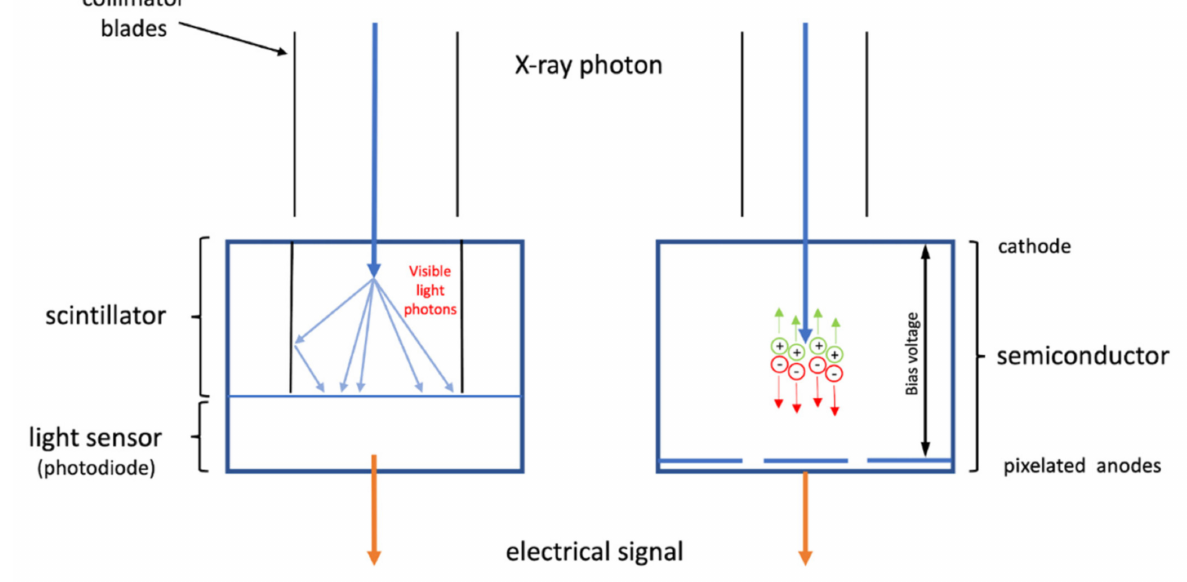
Figure 1. Schematic representation of two different CT systems as follows: on the left, an integrated energy detector (EIDs) with scintillator and septa. The X-rays absorbed by the scintillator are converted into visible light, and a swarm of photons is absorbed by a photodiode that generates an electrical signal. On the right, a photon-counting detector (PCDs) that directly converts X-rays into an electrical